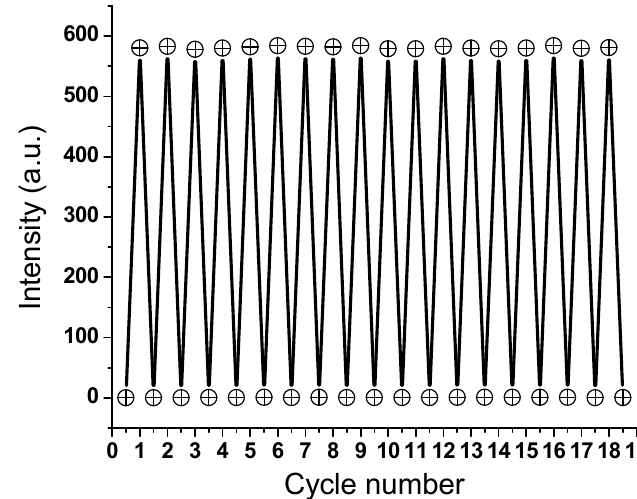
Figure 7. Reversibility of LA 6 (518 nm) below UV and visible lights.